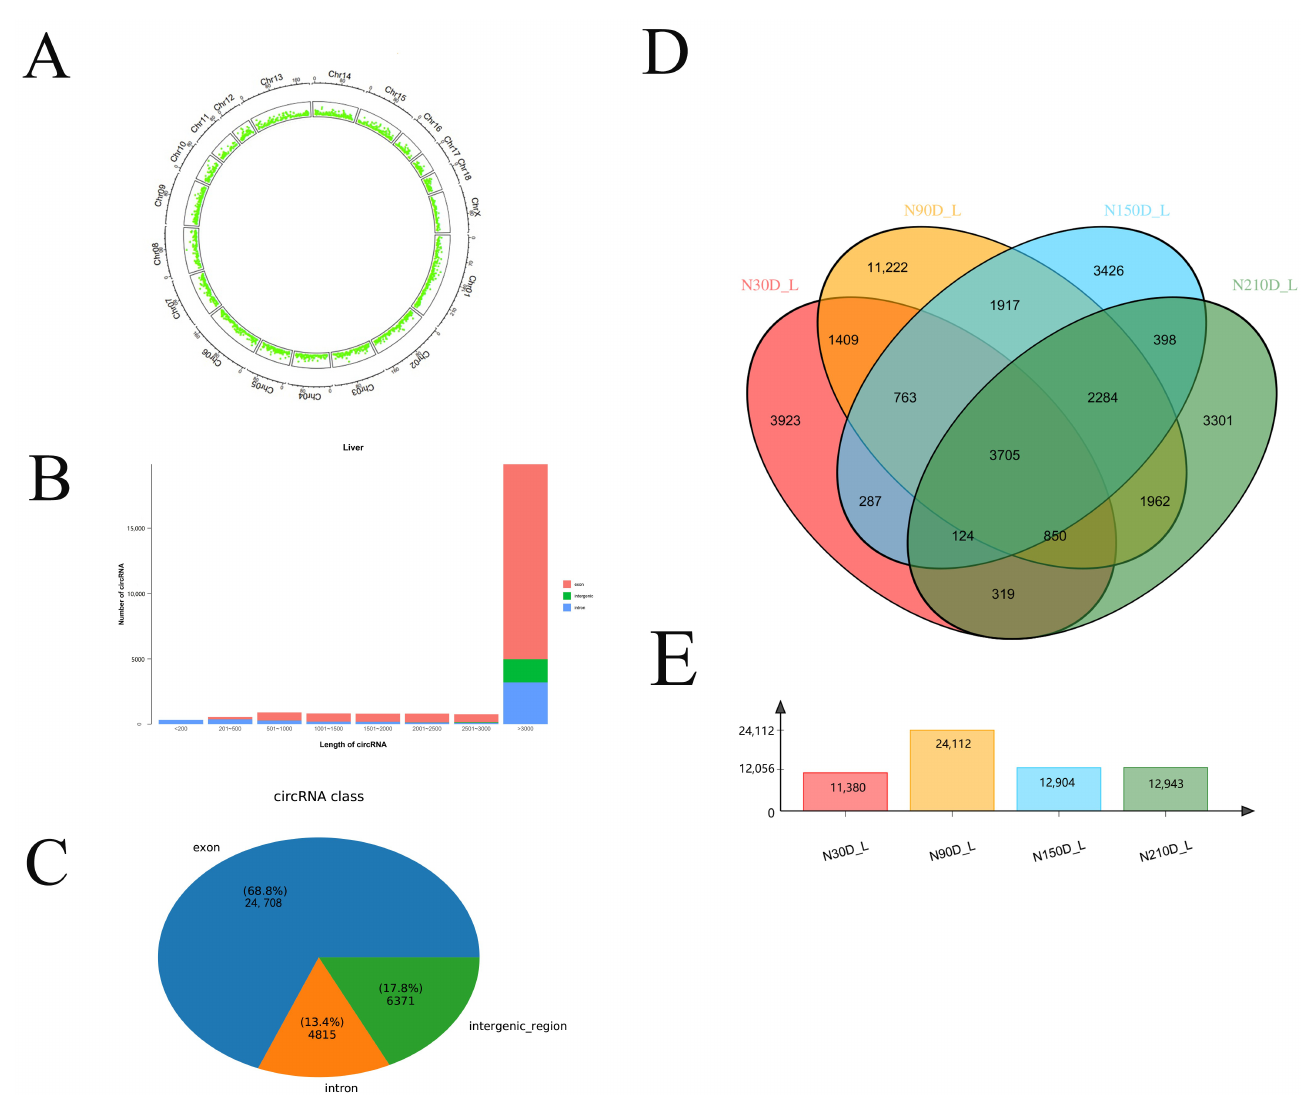
Figure 1. Identification and feature of circRNAs in Ningxiang pig: ( A ) distribution of circRNAs in each chromosome; ( B ) classification and length distribution of circRNAs in Ningxiang pig liver; ( C ) Venn diagram of circRNAs identified at four development points in liver of Ningxiang pigs; ( D ) Venn diagram of circRNAs identified at four development points in liver of Ningxiang pigs; ( E ) Number of circRNAs identified at four development points in liver of Ningxiang